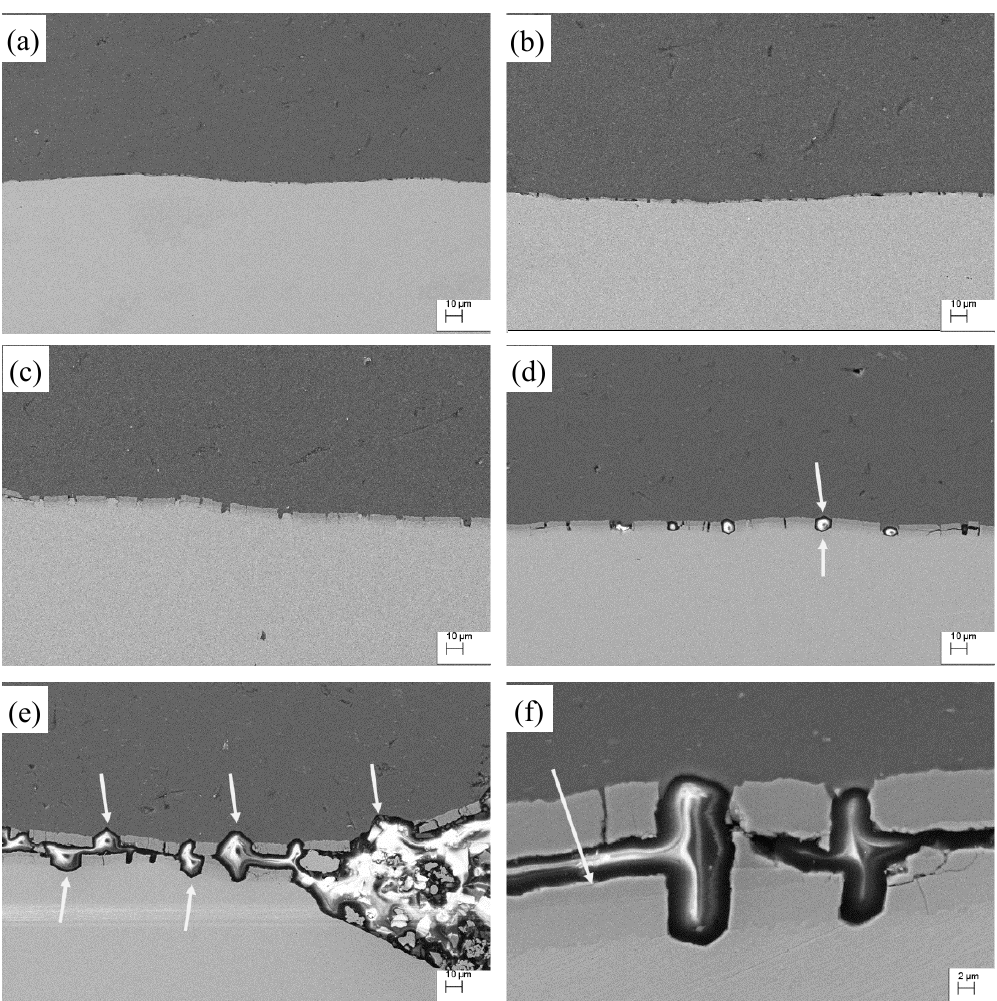
Figure 9. Variation of the intermetallics close to the fracture plane after tensile test. The tensile samples were annealed at ( a ) 300 °C; ( b ) 325 °C; ( c ) 350 °C; ( d ) 400 °C; ( e ) and ( f ) 450 °C.